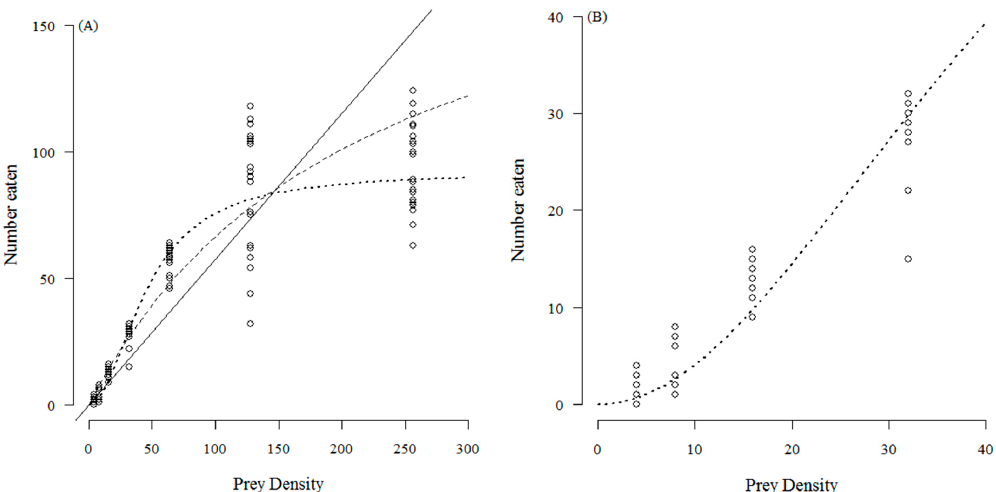
Figure 3. Number of T. absoluta eggs eaten during 24 h by the mirid predator M. basicornis when offered four, eight, 16, 32, 64, 128 and 256 eggs. The dotted curve—a type III functional response—describes the data best. The drawn line represents the fit for a type I response, and the dashed curve for a type II response. The open circles represent the values found for each replicate; 25 replicates were done for each prey density; ( A ) shows the full range of tested densities; ( B ) shows the curve at the four lowest densities to confirm the sigmoidal functional response.